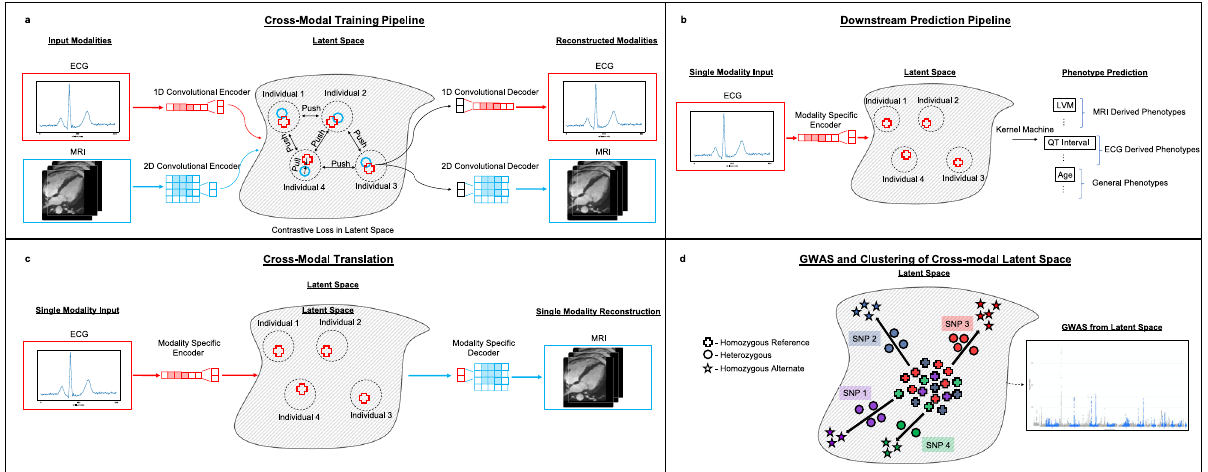
Fig.1|Anoverviewofourcross-modalautoencoderframeworkforintegrating cardiovascular data modalities. Our model is trained on ECG and cardiac MRI pairs from the UK Biobank. a A visualization of our training pipeline. Modality- speci fi c encoders map data modalities into a shared latent space in which a con- trastive loss is used to enforce the constraint that paired samples are embedded nearby and further apart from other samples. Modality speci fi c decoders are then used to reconstruct modalities from points in the latent space. b Learned cross- modal representations are used for downstream phenotype prediction tasks by training a supervised learning model (e.g., a kernel machine) on the